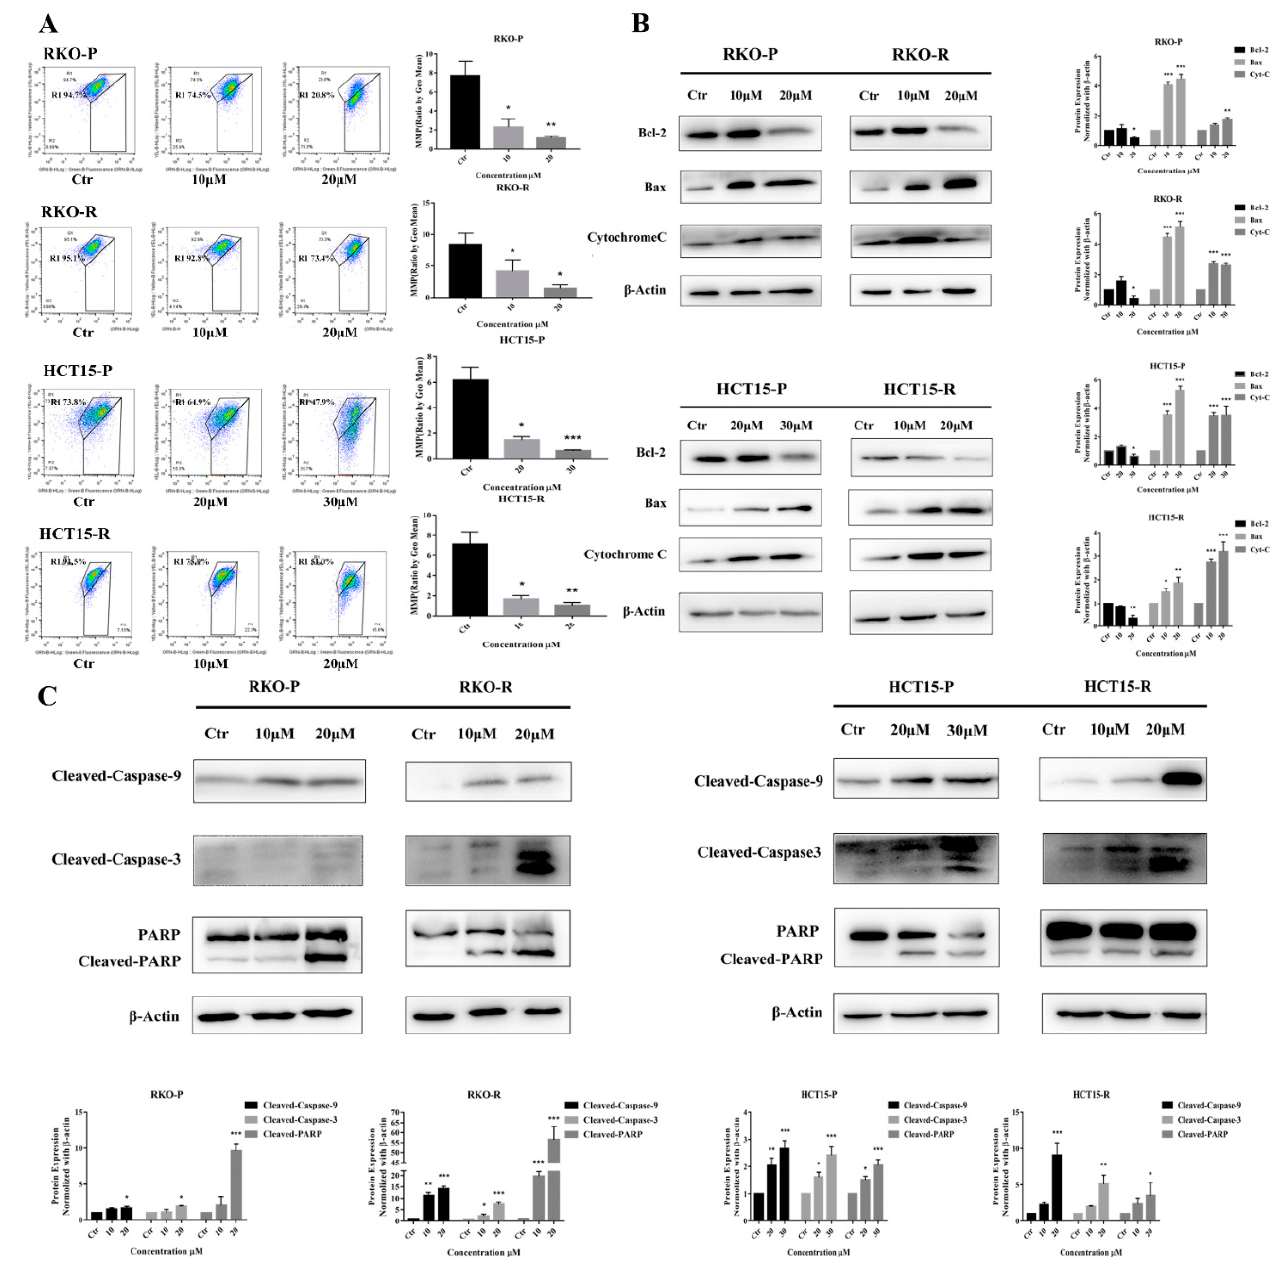
Figure 3. AGE induced apoptosis via mitochondrial-caspase-dependent pathway in 5-FU-sensitive/resistant CRC cell lines. ( A ): The MMP levels of cell lines were determined by JC-1 after 24 h of AGE treatment and measured by mean light intensity of red-green fluorescence. The results of MMP levels are on the right. ( B ): Following the treatment with AGE for 24 h, the expression levels of Bcl-2, Bax, and Cytochrome C proteins were determined by Western Blot and analyzed by β -Actin. The results are presented in right histograms. ( C ): Effects of 24 h treatment with AGE on the expression levels of cleaved-caspase-9, cleaved-caspase-3 and cleaved-PARP proteins in 5-FU-sensitive/resistant cell lines. The analysis results are shown below. Results are expressed as mean ± SD ( n = 3). * p < 0.05, ** p < 0.01, *** p < 0.001, compared with Ctr group.